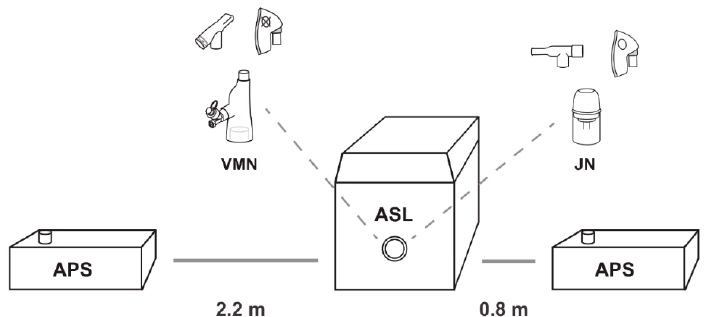
Figure 1. Aerodynamic particle sizer (APS) at varying distances relative to the simulated patient (ASL 5000) with VMN and JN facemask/mouthpiece iterations. VMN, vibrating mesh nebuliser; JN,